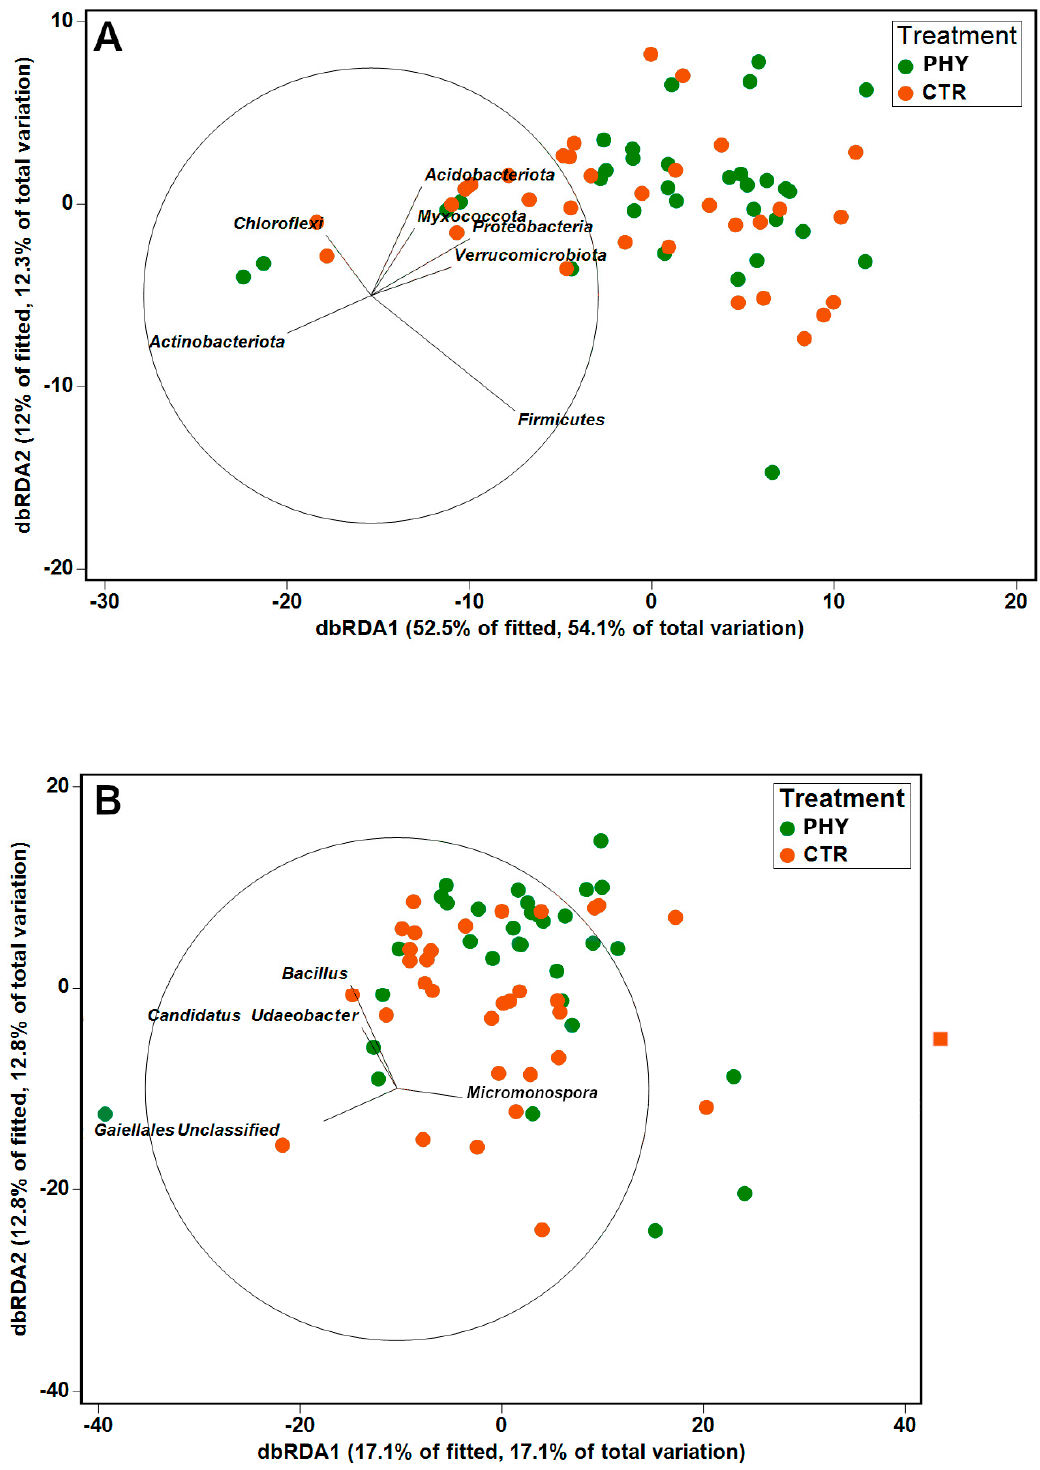
Figure 3. dbRDA plot at a phylum ( A ) and genus ( B ) level. Only the top taxa explaining the difference between the treatments are shown as loading vectors depicting their relative contribution in predicting the differences between PHY and